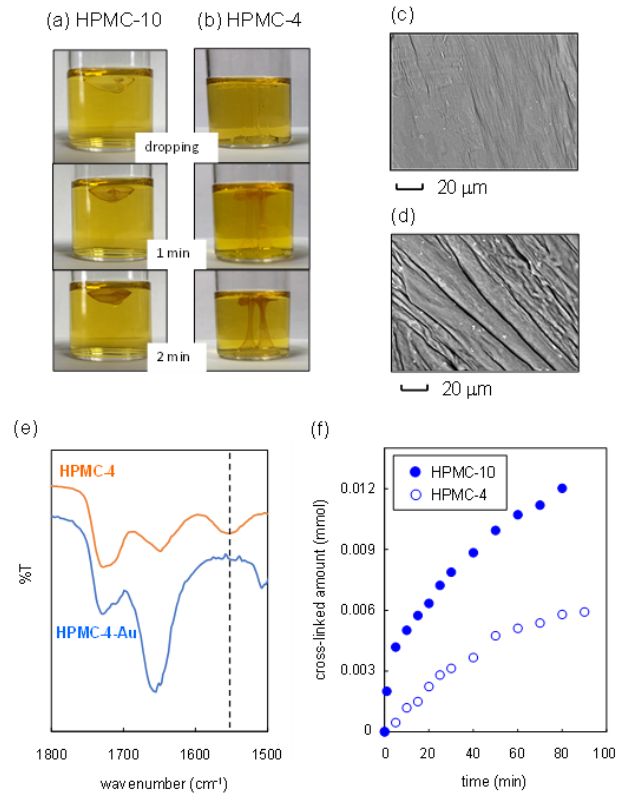
Figure 3. Gelation behavior of Pd II with ( a ) HPMC ― 10 and ( b ) HPMC ― 4. SEM images of ( c ) HPMC ― 10 ― Pd and ( d ) HPMC ― 4 ― Pd. ( e ) IR spectra of HPMC ― 4 and HPMC ― 4 ― Au. ( f ) Cross- linking rates of HPMC ― 4 and HPMC ― 10.